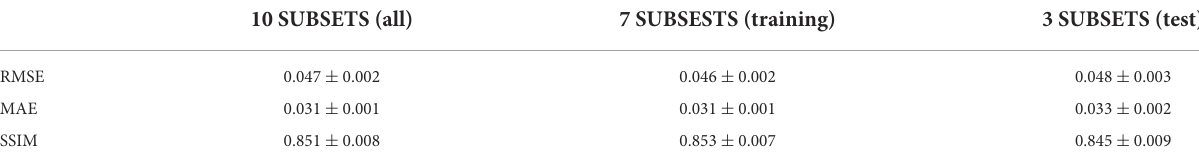
TABLE 1 Performance metrics in HCP dataset.